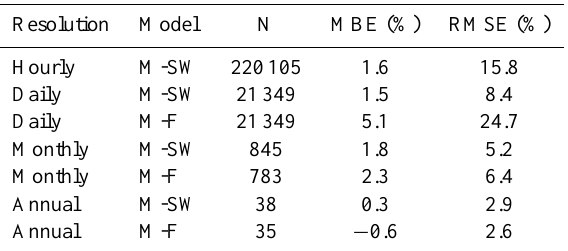
Figure 3. Parameters a (left), b (middle), and B (right) calculated for different sunshine fraction ( F ) intervals. The error bar represents the combined uncertainty. Table 2. Statistical estimators calculated with N pairs of measured and reconstructed UVER radiation for M-SW and M-F models and for different temporal resolutions. The hourly values were obtained using data with SZA below 80 ◦